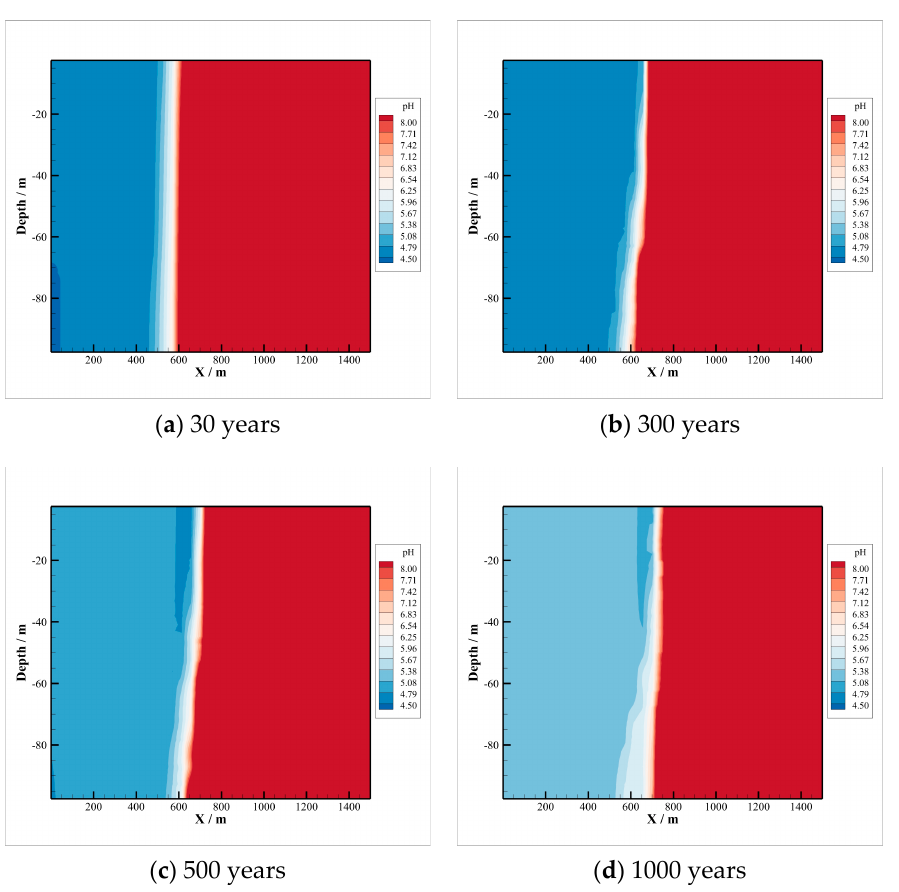
Figure 4. Variations in pH in